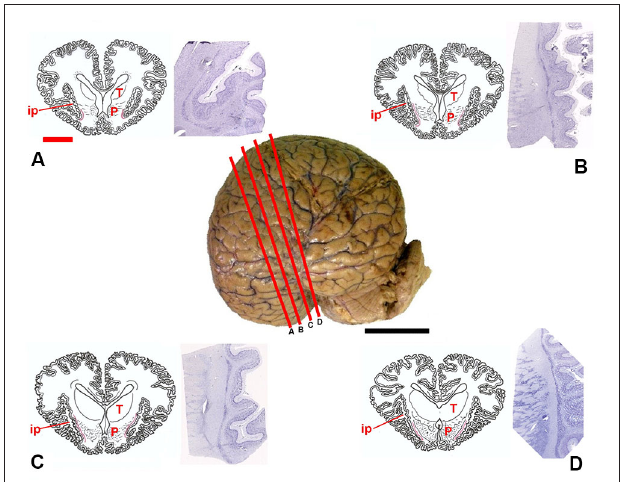
FIGURE 1 | Position of the claustrum in Tursiops truncatus . Center, lateral photograph of the adult brain; the orange bars (A–D) approximate the levels of subsequent sections. The drawings (A–D) are based on composite renderings of coronal sections of the dolphin brain, sided by Nissl preparations obtained approximately at the corresponding levels. In the drawings the claustrum is represented by a thin red line. Note the reduction of the endopiriform cortex ventral to the basal ganglia; P, putamen; T, thalamus; ip, insular pocket. Black scale bar (lateral photograph of the dolphin brain) = 5 cm; orange scale bar (drawings) = 2